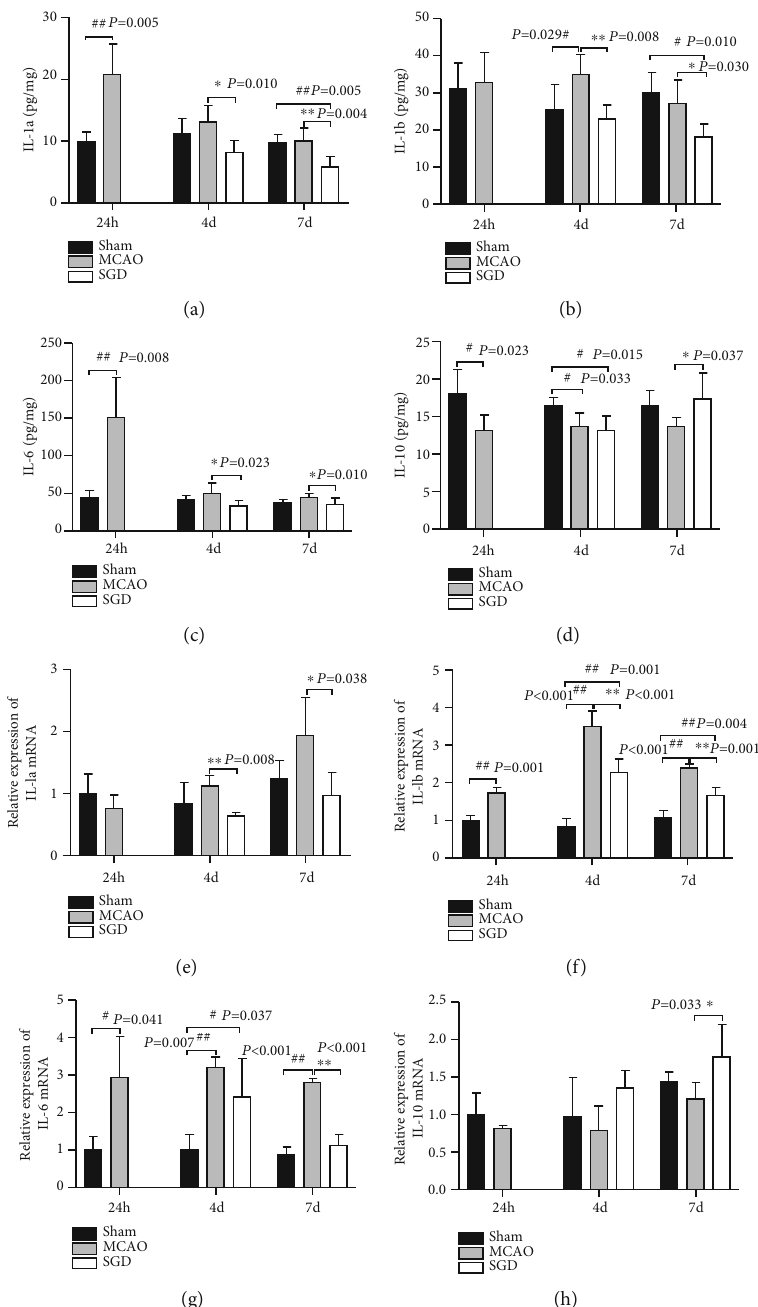
Figure 5: SGD induced a decline in M1-like markers and an elevation of M2-like markers. Luminex and qRT-PCR were performed to determine the expression of phenotypic markers in the sham, MCAO, and SGD groups at 24h, 4d, and 7 d after CI/RP. The corresponding statistical histograms of M1 markers, IL-1a (a, e), IL-1b (b, f), IL-6 (c, g), and the M2 marker IL-10 (d, h) are displayed. Results are presented as the mean ± SD , n = 4 − 5 for Luminex, and n = 3 − 4 for qRT-PCR in each group. # P < 0 : 05 , ## P < 0 : 01 vs. sham; ∗ P < 0 : 05 , ∗∗ P < 0 : 01 vs.